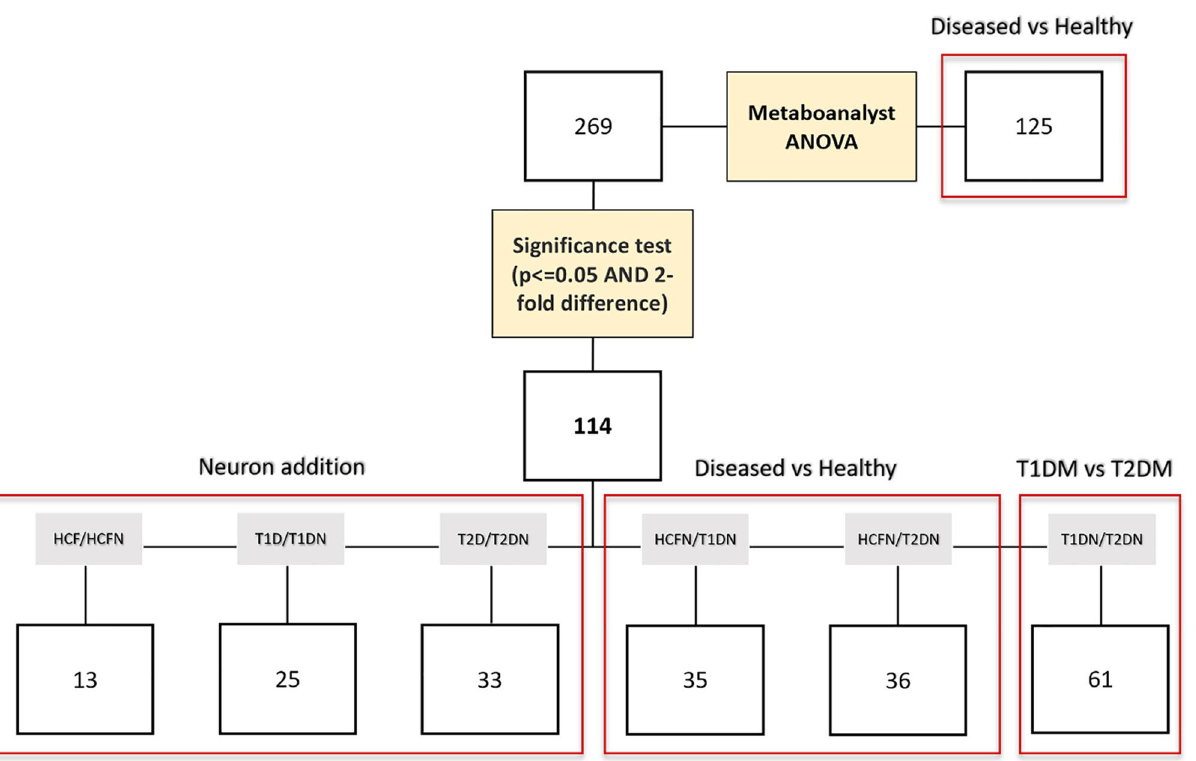
Figure 1. Summary of metabolic impact of neuronal presence in HCFs, T1DMs, T2DMs. A total of 269 metabolites were analyzed via one-way ANOVA on Metaboanalyst. Individual t tests were utilized for the 6 comparisons listed above: HCF/HCF-N, T1D/T1DM-N, T2D/T2DM-N, HCF-N/T1DM-N, HCF-N/T2DM-N, T1DM-N/T2DM-N. Only metabolites that reached a 2-fold change and a significance of p < 0.05 were deemed significant. All samples analyzed for metabolites had a n =